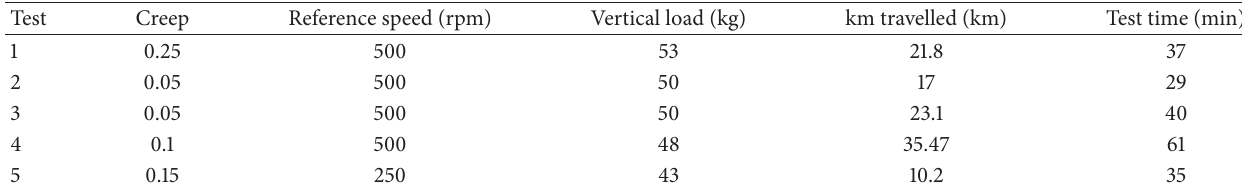
Table 5: Tests performed to evaluate the wear on the wheels and the rollers.